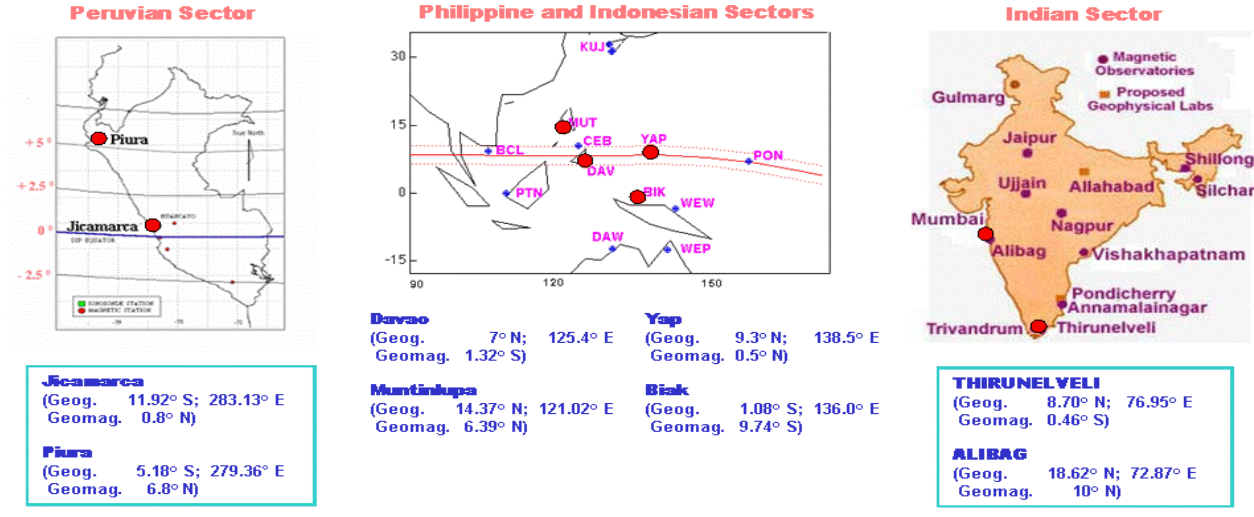
Figure 2. The geomagnetic coordinates for the Peruvian, Philippine, Indonesian and Fig. 2. The geomagnetic coordinates for the Peruvian, Philippine, Indonesian and Indian magnetometer locations. Indian magnetometer locations. sectors and averaged over the same seasonal periods in